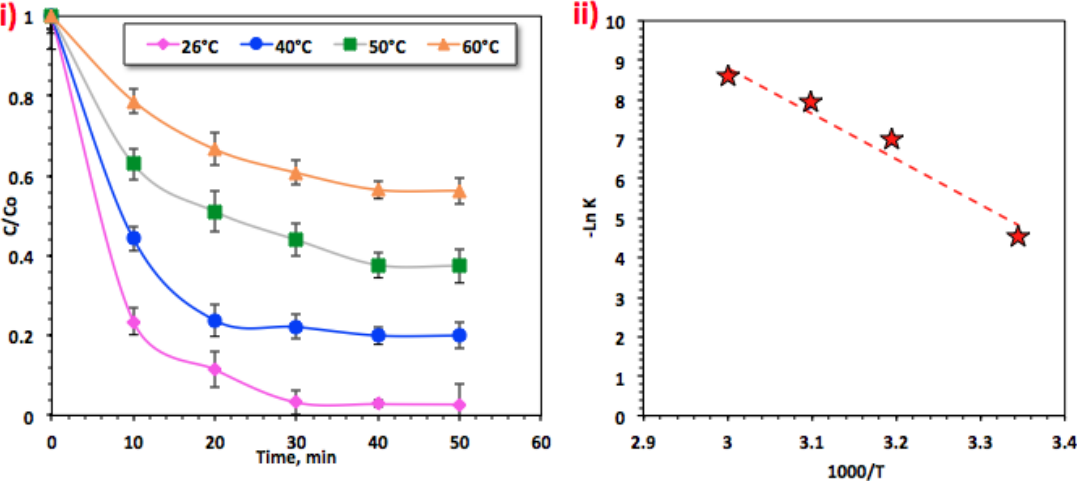
Figure 11. Effect of temperature on the reaction: ( i ) effect of temperature on the aqueous matrix in the photo-Fenton system, and ( ii ) plot of ( − Ln K) vs. 1000/T.